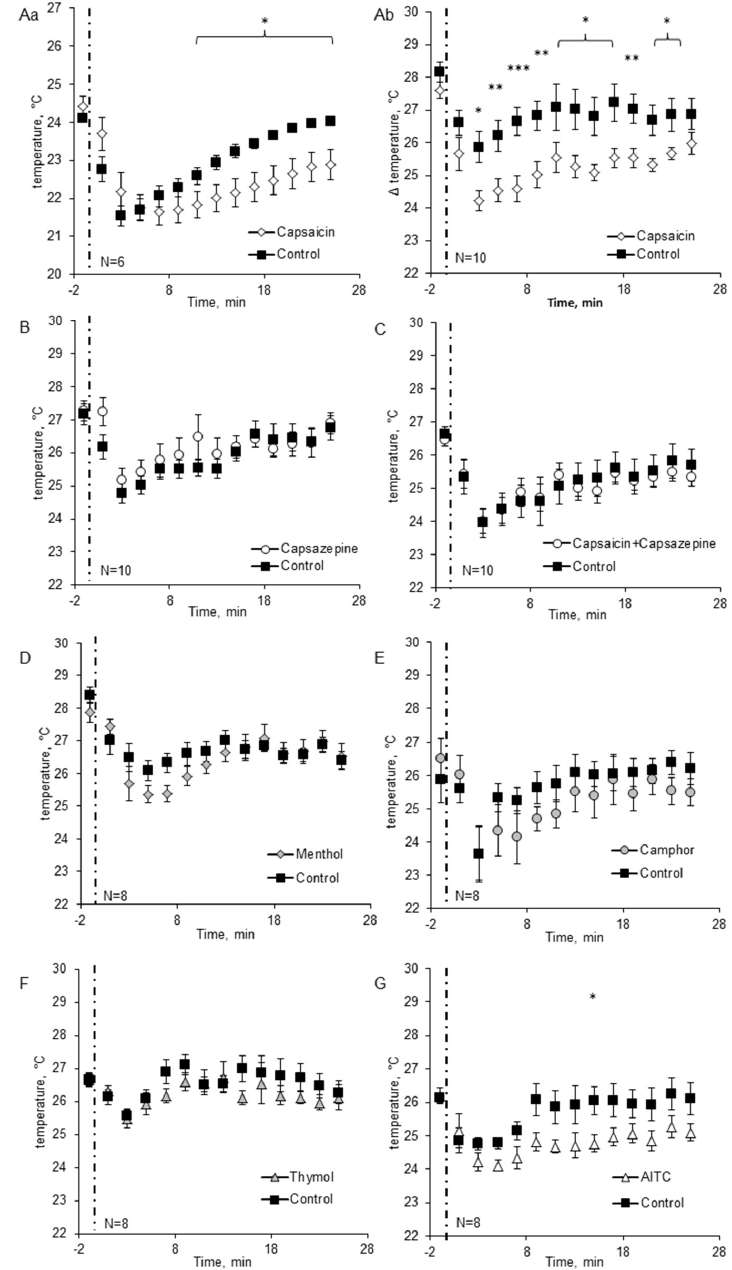
Figure 2. The temperature of the head of the cockroaches treated with TRP ligands ( A ). Changes of head temperature induced by 1 µM capsaicin measured using ( a ) thermocouple system and ( b ) thermal camera. Changes of the head temperature induced by 1 µM capsazepine ( B ), 1 µM capsazepine + 1 µM capsaicin ( C ), 0.1 mM menthol ( D ), 10 mM camphor ( E ), 1 mM thymol ( F ) and 0.1 mM AITC ( G ) measured with thermal camera. Time of application of tested substances is marked by dashed line. Data are presented as mean ± standard error of the mean (SEM). Note that the first data points on each graph refer to the moment just before the application. * indicates values significantly different vs. control group: * p < 0.05; ** p < 0.01; *** p < 0.001; least significant difference (LSD) test. The group sizes are indicated on the figure.